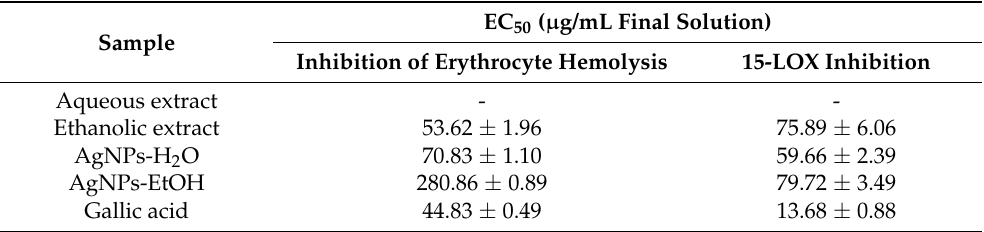
Table 2. EC 50 values of T. erecta extracts and of their corresponding AgNPs obtained in the antioxidant assays .